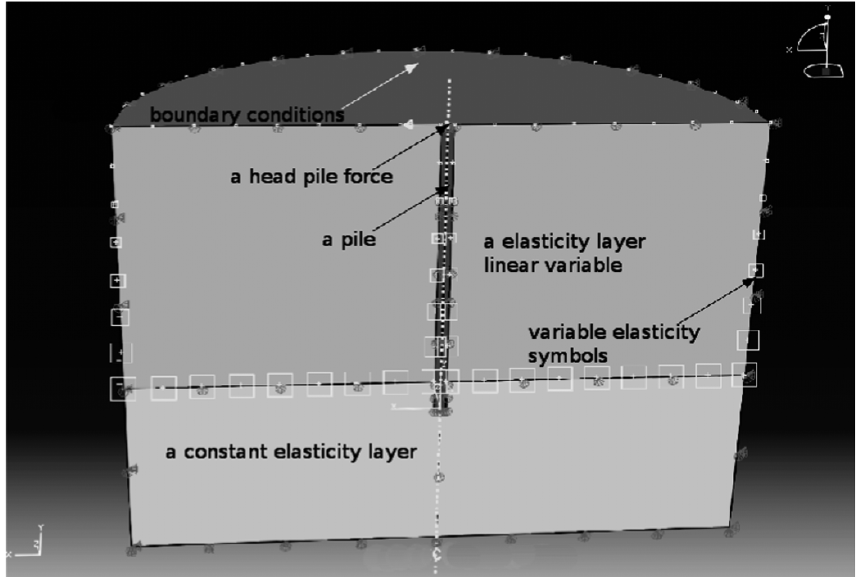
Fig. 3. The pile under consideration in the second subsoil